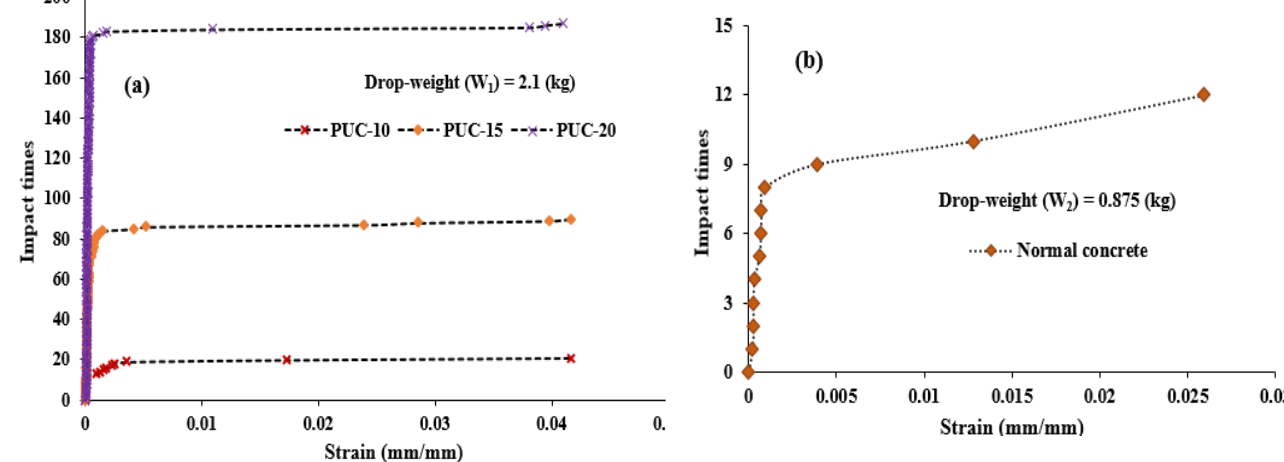
Figure 7. Impact times-strain curves: ( a ) PUPC and ( b ) normal concrete specimens.